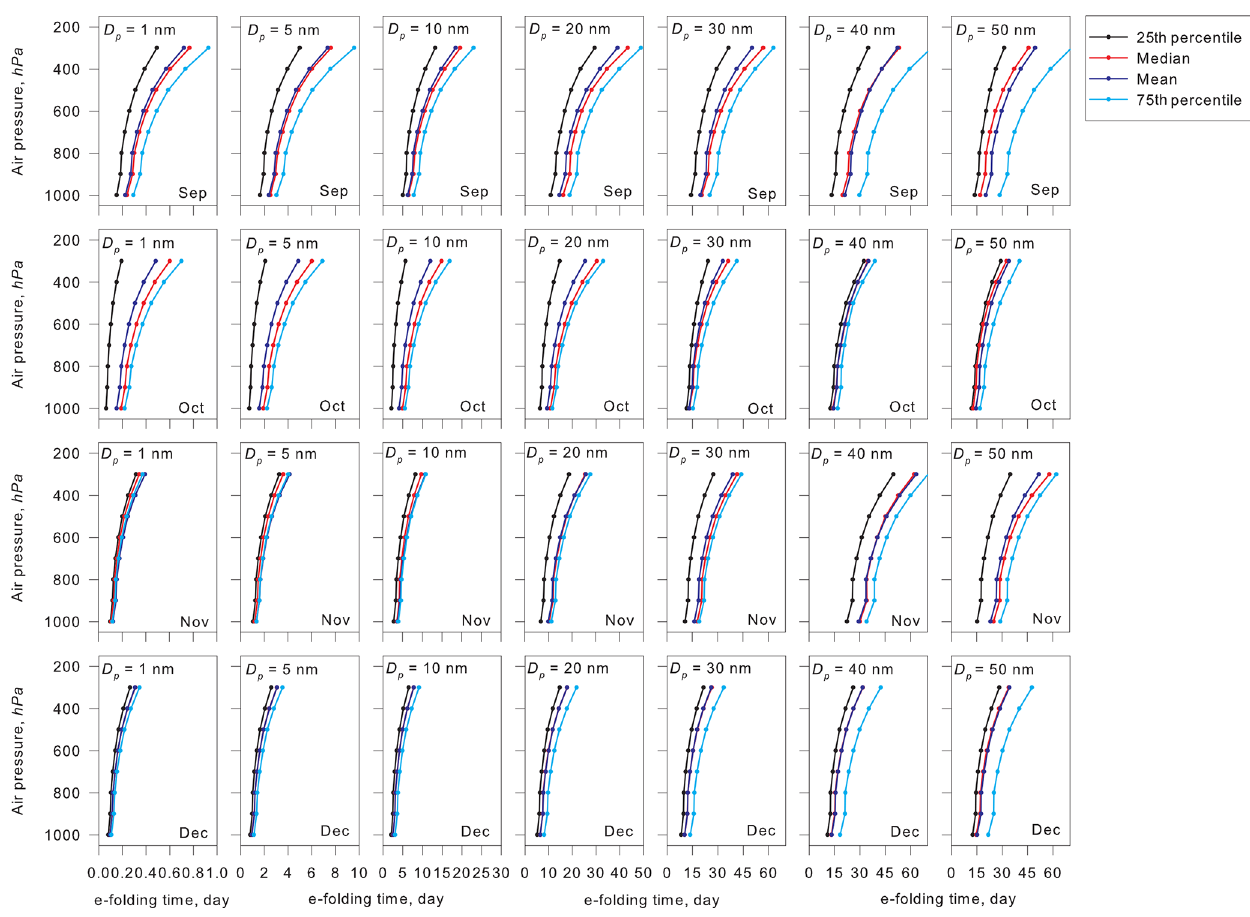
Figure 8. Vertical variations of aerosol e -folding time of coagulation loss in respective sizes in the troposphere over Syowa Station, Antarc- tica, during